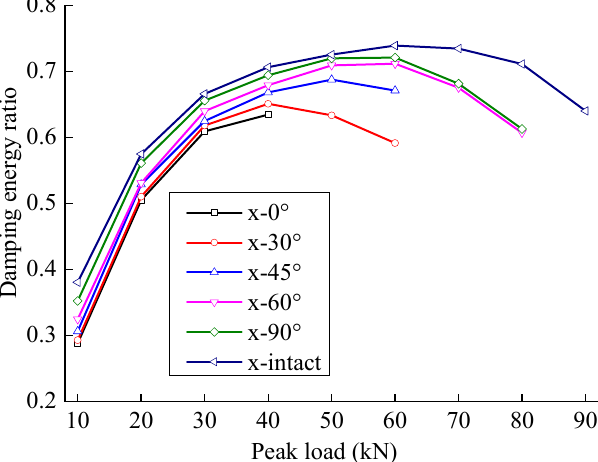
Figure 15. Damping energy ratio evolution curve of sandstone with different crack angles.